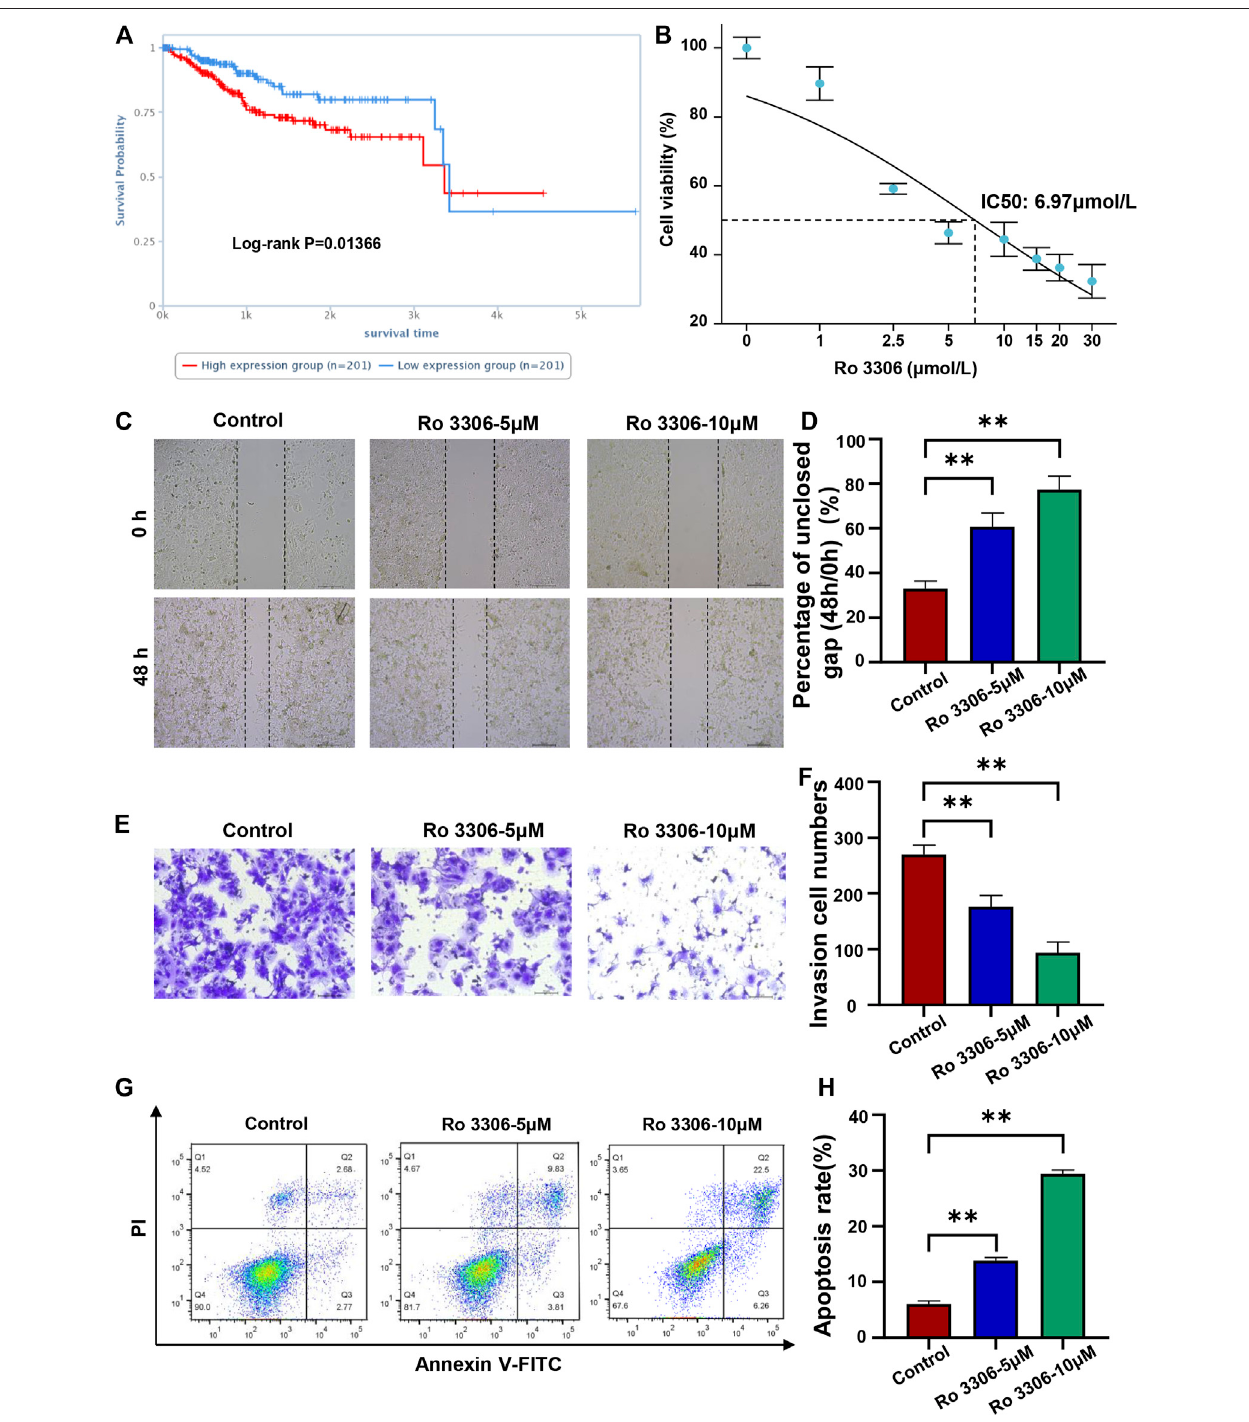
FIGURE 9 | Inhibition of CDK1 inhibits the migration and promotes the apoptosis of EC cells (A) . High expression of CDK1 protein was closely related to the poor prognosis of EC patients ( p < 0.05). The cancer proteome atlas (https://www.tcpaportal.org/tcpa/survival_analysis.html) (B) . The CCK-8 showed that the IC50 of Ro 3306 on Ishikawa cells was 6.97 μ mol/L (C,D) . The scratch test revealed that compared with control group, cells treated with 5 μ M or 10 μ M Ro 3306 showed signi fi cantlyincreasedgapsizeofoh (E,F) .Thetranswellexperimentrevealedthatcomparedwithcontrolgroup,cellstreatedwith5 μ Mor10 μ MRo3306showed signi fi cantly decreased invasion cell numbers (G,H) . Detection of apoptosis of Ishikawa cells treated with 5 μ M or 10 μ M Ro 3306 by fl ow cytometry. ** p < 0.01, compared with control.